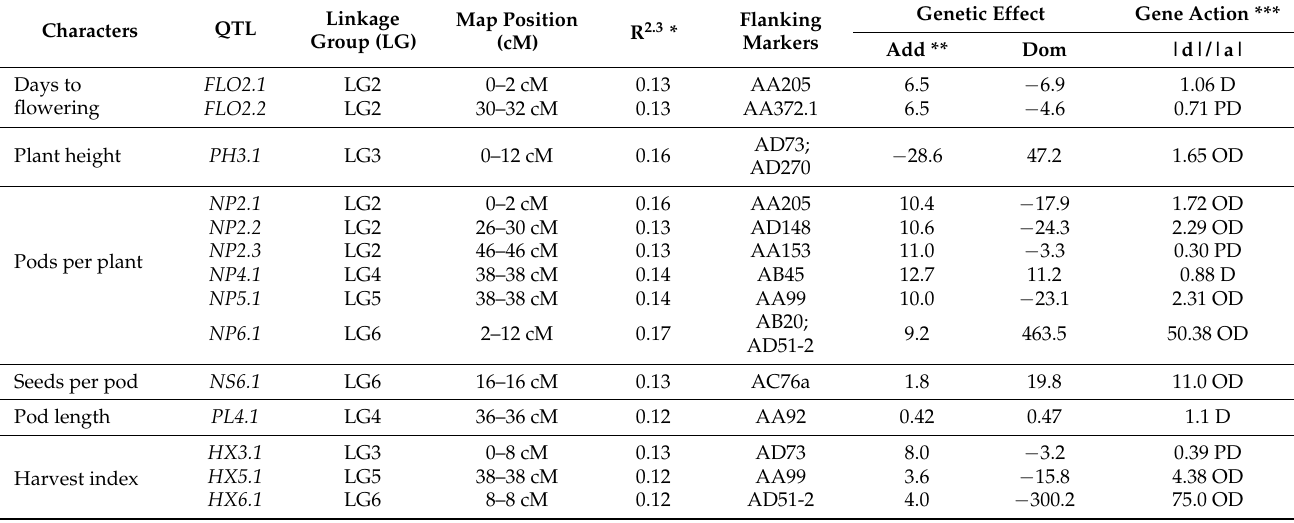
Table 4. QTLs detected for days to flowering, plant height, no. of pods per plant, no. of seeds per pod, pod length and harvest index under glasshouse conditions.